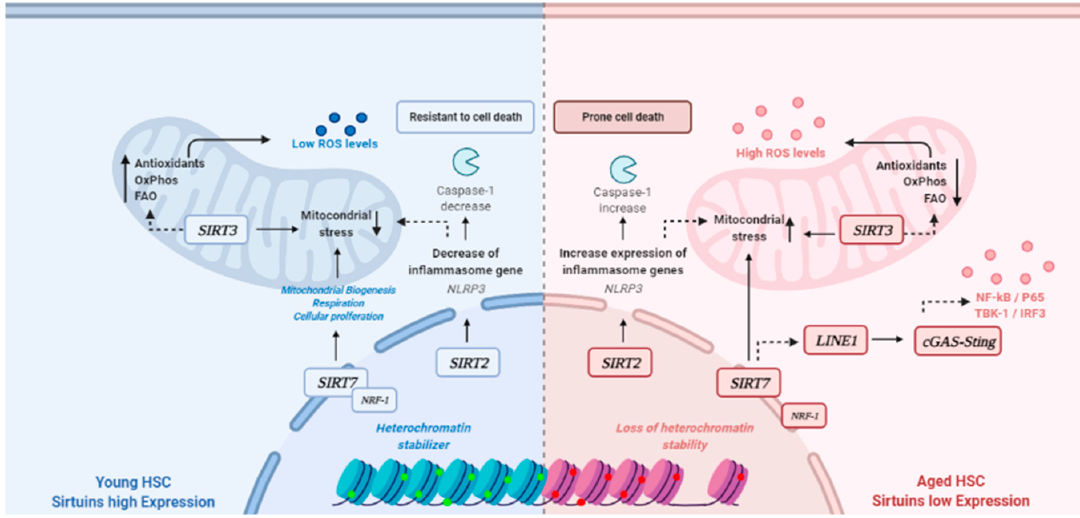
Figure 2. Sirtuins activity pathways in young versus aged HSCs. Legend: FAO: Fatty acid β -oxidation. HSC: Hematological Stem Cells. OXPHOS: Mitochondrial proteins oxidative phosphorylation system.